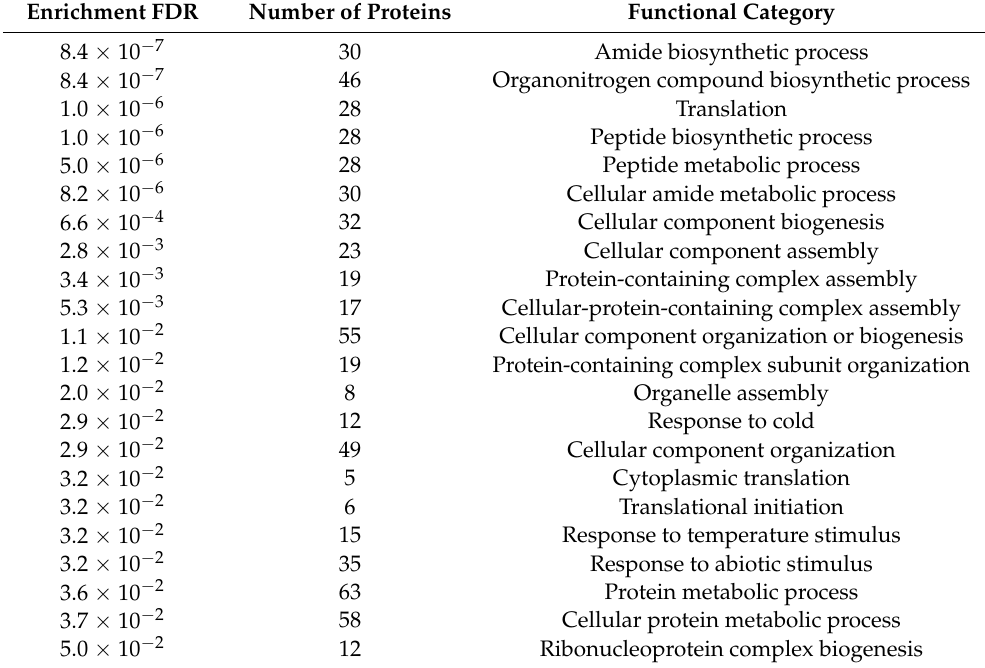
Table 2. GO enrichment analysis of up-regulated proteins specifically in the leaf epidermis at 24